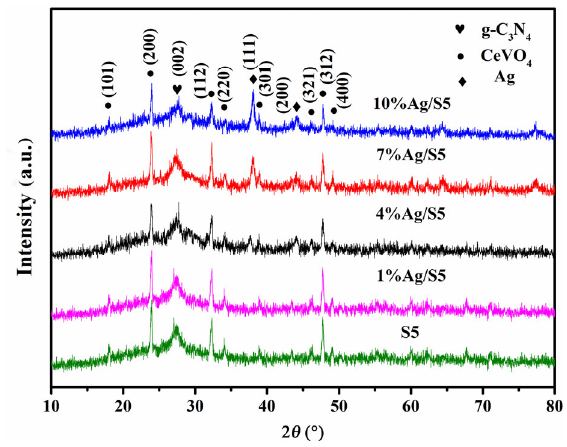
Fig. 2 XRD patterns of S5 and Ag/CeVO 4 /g-C 3 N 4 composites with different contents of